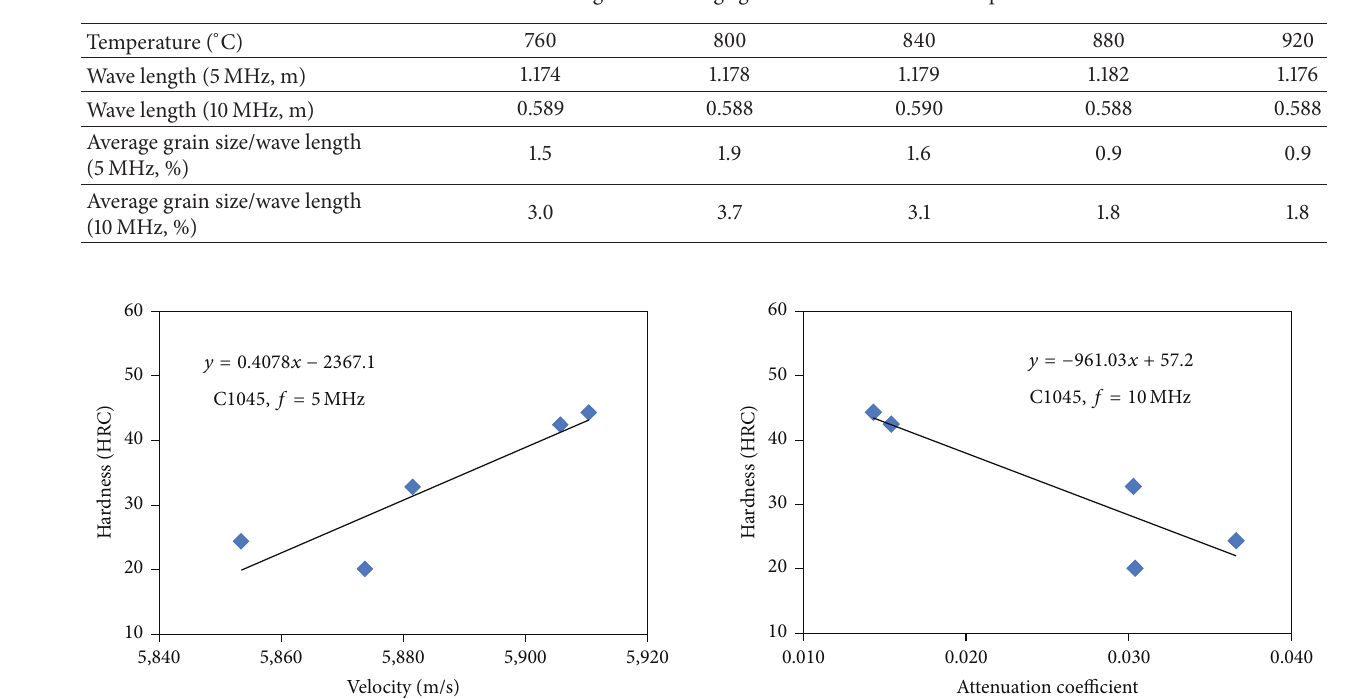
Table 3: Relation of wave length and average grain size with different temperatures.